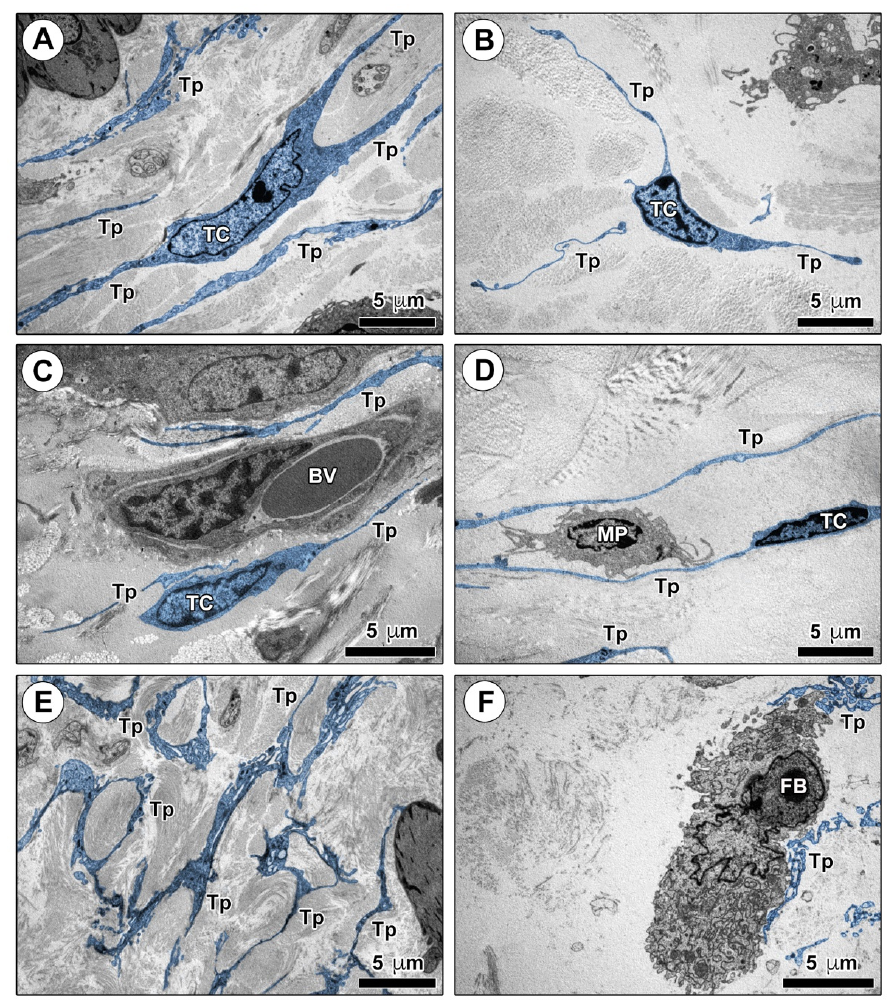
Figure 4. Ultrastructural identification of telocytes (TCs) in control mouse skin. ( A – F ) Representative transmission electron microscopy photomicrographs of skin ultrathin sections from control mice stained with UranyLess and bismuth subnitrate solutions. TCs and telopodes have been digitally colored in blue. TCs are ultrastructurally identifiable as stromal cells characterized by i) a spin- dle-shaped, oval, or piriform cell body with a relatively large euchromatic nucleus surrounded by a scarce cytoplasm, and ii) the presence of telopodes, long cytoplasmic processes with a narrow emergence from the cell body and a moniliform appearance due to the alternation of thin segments (podomers) and expanded portions (podoms). TCs are widely distributed in control mouse dermis, where their long telopodes surround collagen bundles ( A , B ) and blood microvessels ( C ), and estab- lish intercellular contacts with macrophages ( D ). Telopodes often form a labyrinth-like network dis- tributed among dermal collagen bundles ( E ) and contact fibroblasts ( F ). Scale bar: 5 μ m ( A – F ). BV, blood vessel; FB, fibroblast; MP, macrophage; TC, telocyte; Tp, telopode.